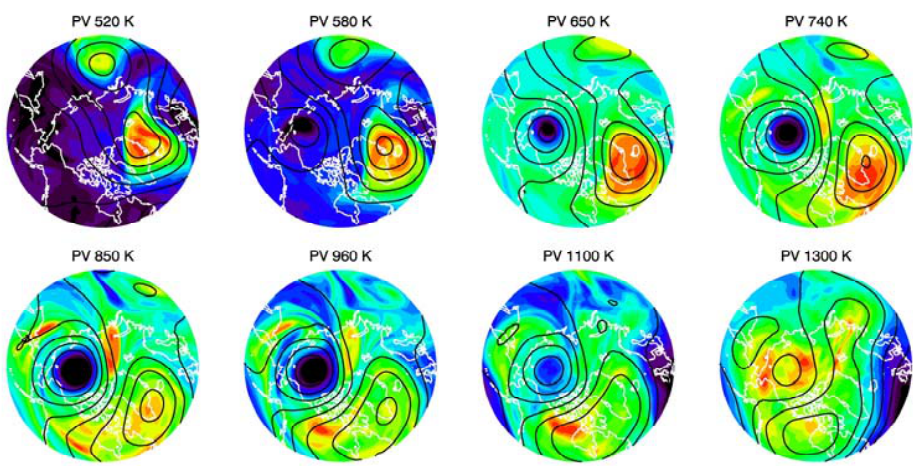
Fig. 3. Ertel potential vorticity at eight potential temperature levels (520, 580, 650, 740, 850, 960, 1100, and 1300K) from 50–90 ◦ N on 4 April 2005 (Greenwich Meridian is on the right side). Colors are scaled to the range of PV values for the given level, with red (blue) indicating high (low) PV. Black lines show 10hPa geopotential height at 100-m contour intervals.